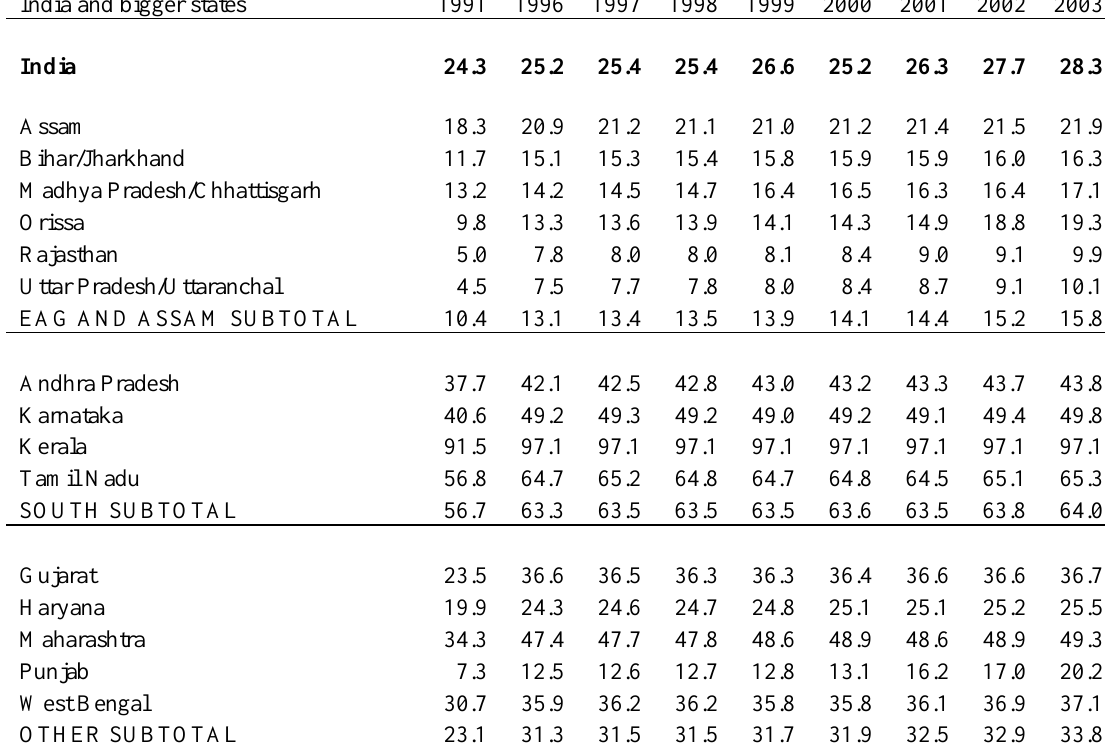
Table 6: Type of medical attention at birth (Institutional),1991-2003 India and bigger